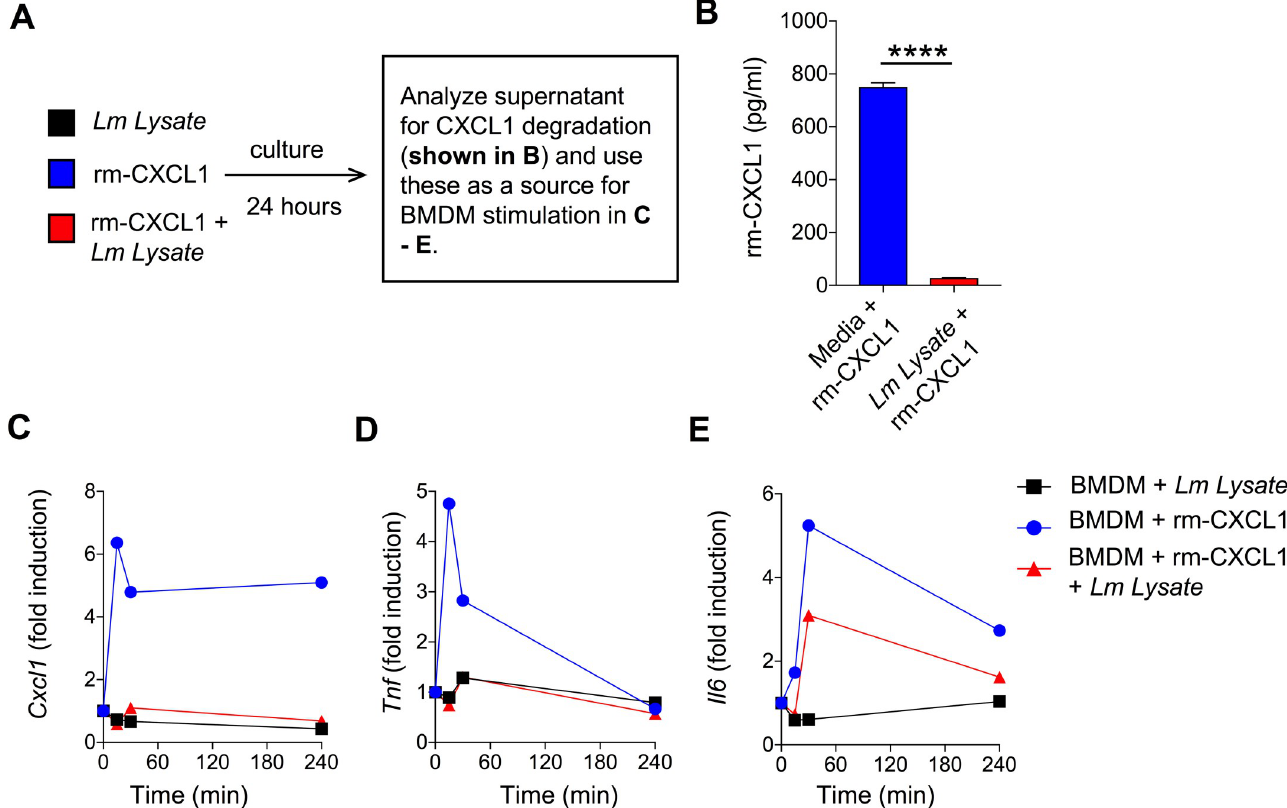
Fig 4. Biological activity of L . major- treated CXCL1 is diminished. (A) Schematic representation of experimental design. (B) Recombinant murine CXCL1 was incubated with Lm lysate for 24h and CXCL1 levels was determined by ELISA. (C-E) BMDMs were treated Lm lysate, rm-CXCL1, or Lm lysate + rm-CXCL1 from (B) for indicated time-points and mRNA expression of pro-inflammatory genes Cxcl1 (C), Tnf (D) and Il6 (E) were evaluated by qPCR. Data are representative of at least three independent experiments.